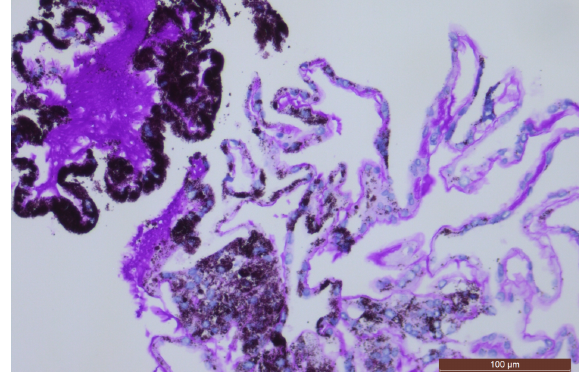
Figure 2: The single layer of cuboidal cells contain a variable amount of pigmented granules and are lined with a PAS-positive basementmembrane(periodicacid-Schiff staining x20).